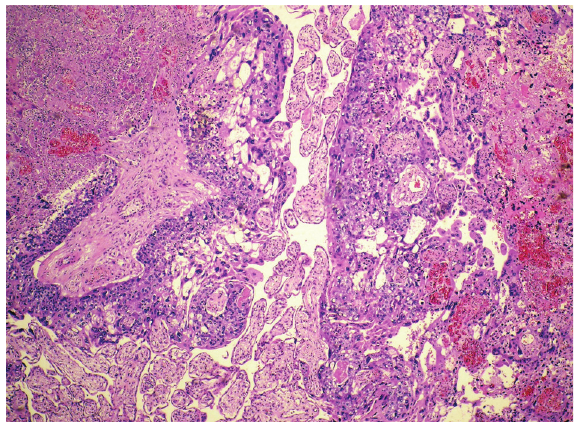
Figure 1: Intraplacental choriocarcinoma growing out from stem villi sharply demarcated from surrounding normal villi (H&E × 40).